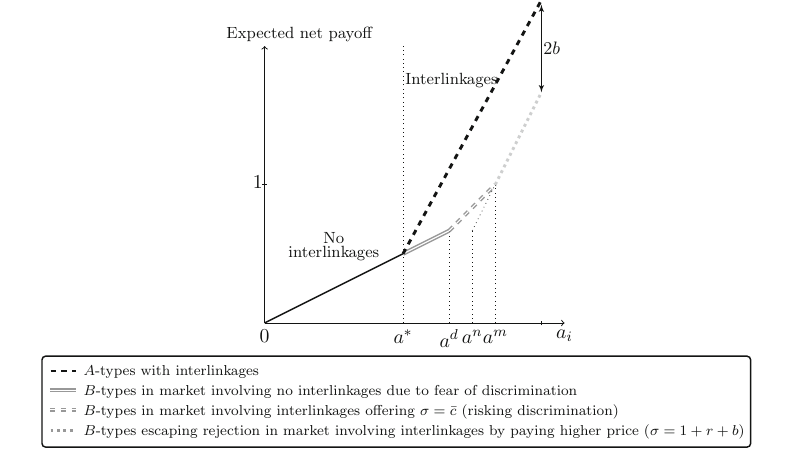
Fig.3 Ability levels and choice of market (interlinkages vs. no strategic interlinkages) with discrimination